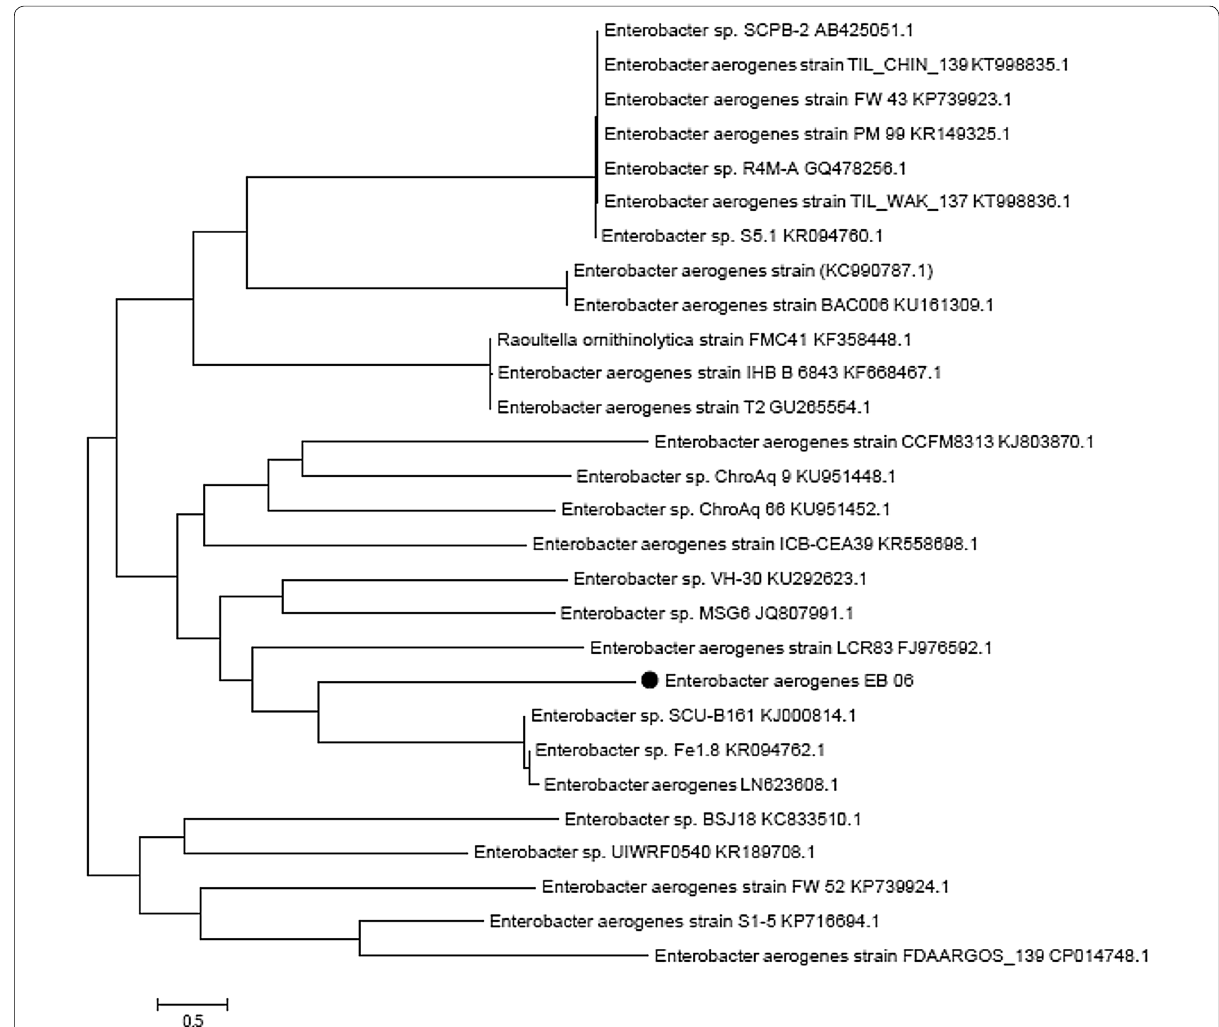
Fig. 2 The phylogenetic tree of EB-06 based on 16S rDNA sequences